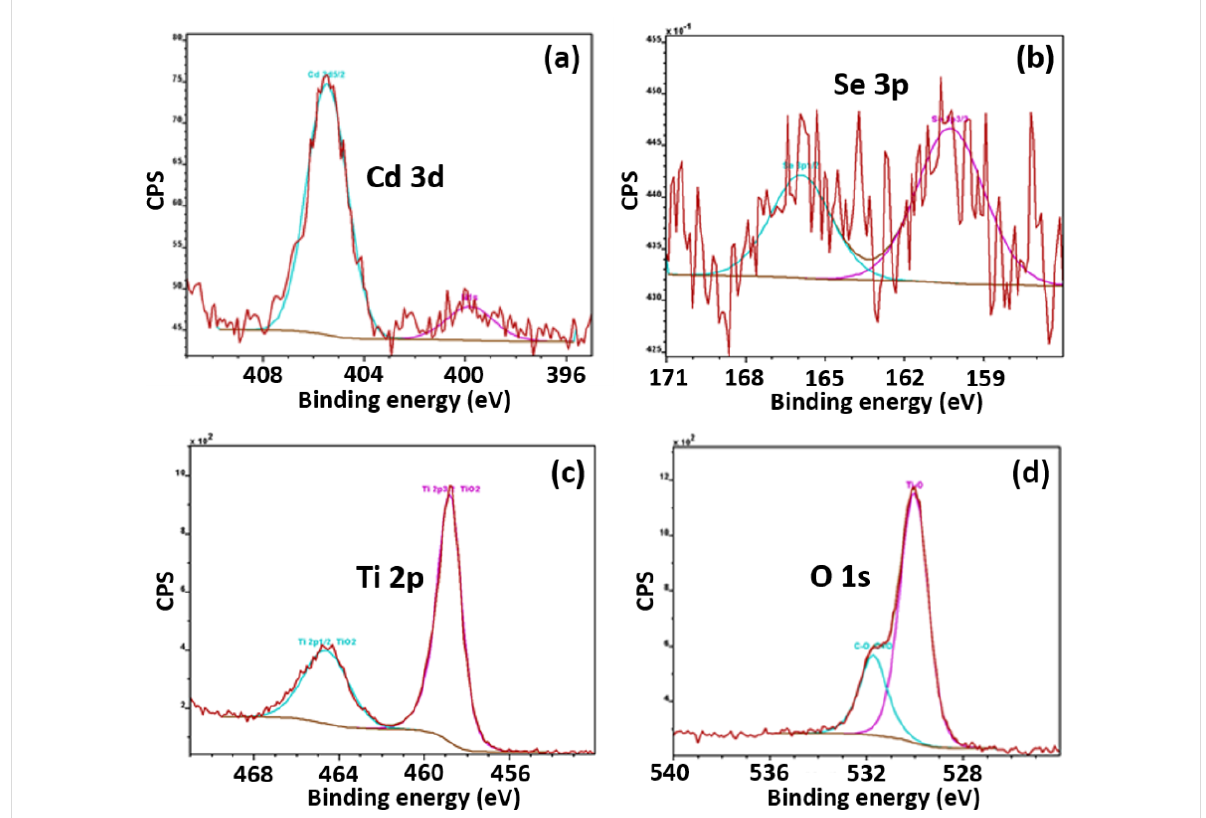
Figure 5: High-resolution XPS spectra of the CdSe (2 wt %)/TiO 2 composite: (a) Cd 3d, where Cd 3d 5/2 (blue) at 405.46 eV comprised 45.18% of the area of the spectra and N 1s (pink) at 399.81 eV comprised 54.82% of the area of the spectra; (b) Se 3p, where Se 3p 1/2 (blue) at 165.91 eV comprised 50.09% of the area of the spectra and Se 3p 3/2 (pink) at 160.26 eV comprised 49.91% of the area of the spectra; (c) Ti 2p, where Ti 2p 1/2 (blue) at 464.56 eV comprised 44.72% of the area of the spectra and Ti 2p 3/2 (pink) at 458.74 eV comprised 55.28% of the area of the spectra and (d) O 1s, where C–O C=O (blue) at 531.72 eV comprised 24.81% of the area of the spectra and Ti–O (pink) at 530.00 eV comprised 75.19% of the area of the spectra. CPS = counts per